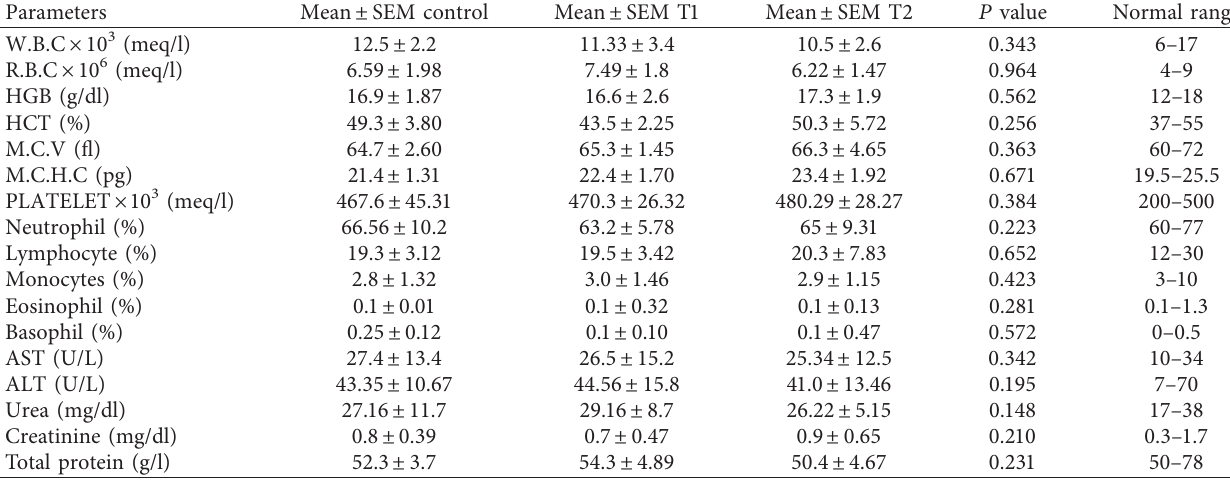
Table 1: Biochemical and hematological parameters evaluated in the controlled and treated groups. Parameters